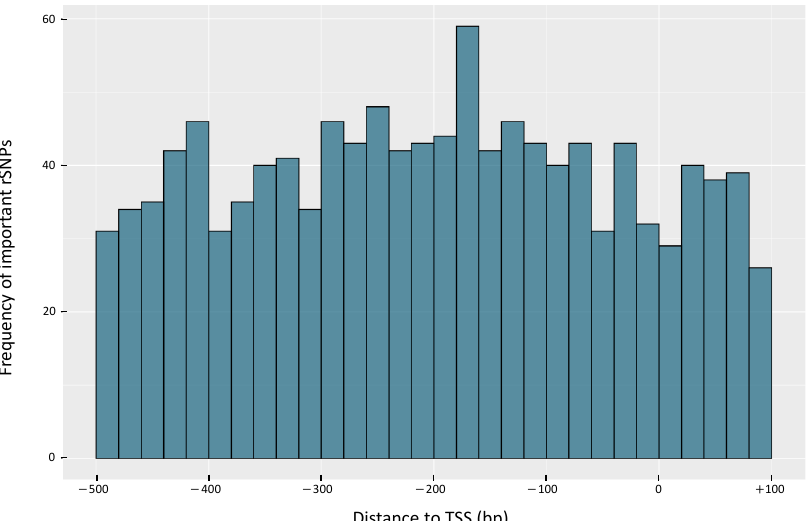
Figure 4. Distribution of important rSNPs relative to the transcription start sites (TSS) of the corre- sponding genes. Position 0 denotes the position of the